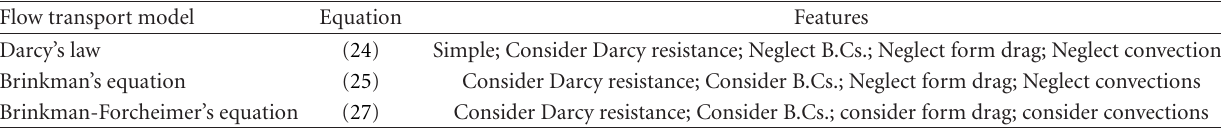
Table 1: Summary of the flow transport models in porous media